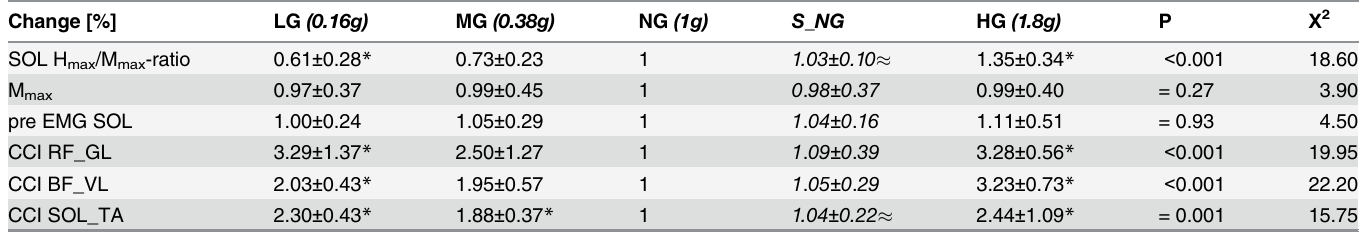
Table 3. Changes in H max /M max - ratio, SOL pre-activation and CCI for the antagonistic muscle groups RF_GL, BF_VL and SOL_TA in response to the gravity variation (Lunar (LG), Martian (MG), normal (NG), simulated normal (S_NG) and hypergravity (HG)). Change